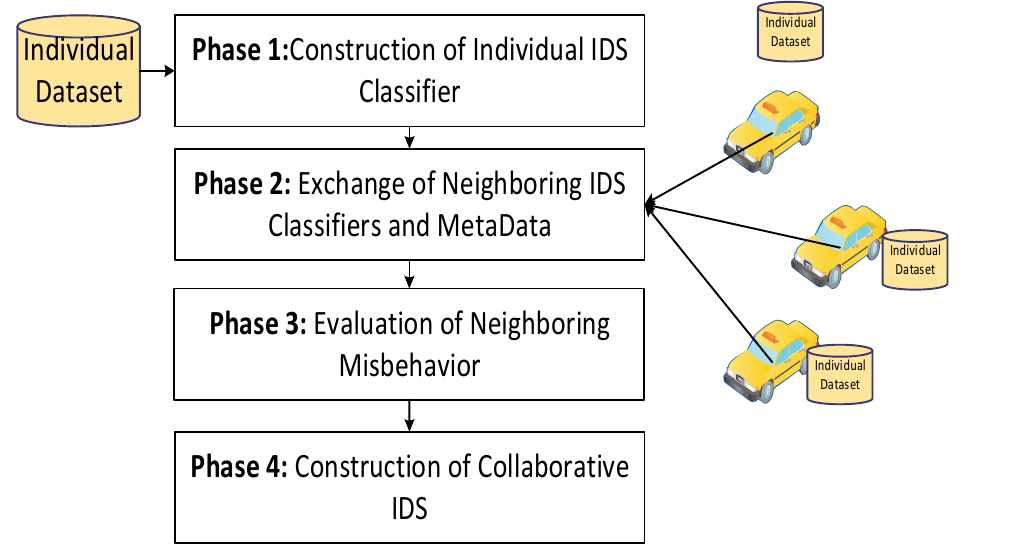
Figure 1. Architecture of the misbehavior-aware on-demand collaborative intrusion detection system (MA-CIDS) model.